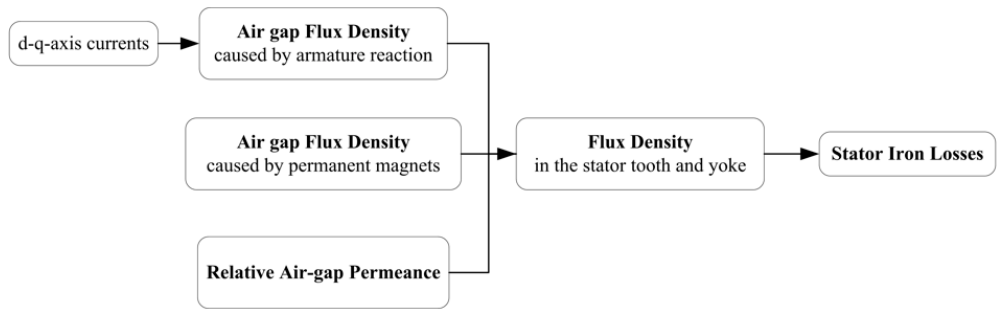
Figure 1. Stator iron losses calculation principle of SPM machines.